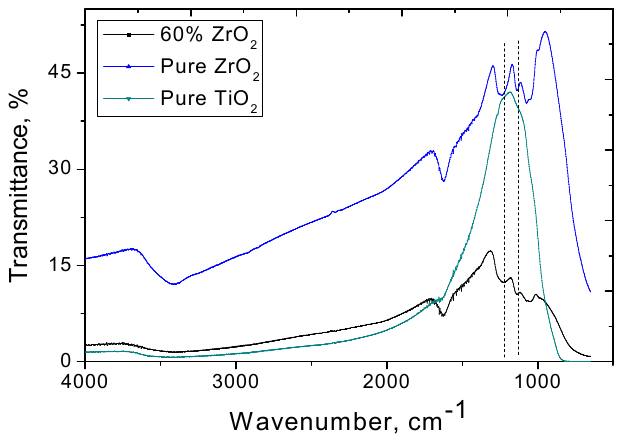
Figure 2. IR spectrum of 60 wt.% ZrO 2 -TiO 2 , pure TiO 2 and pure ZrO 2.